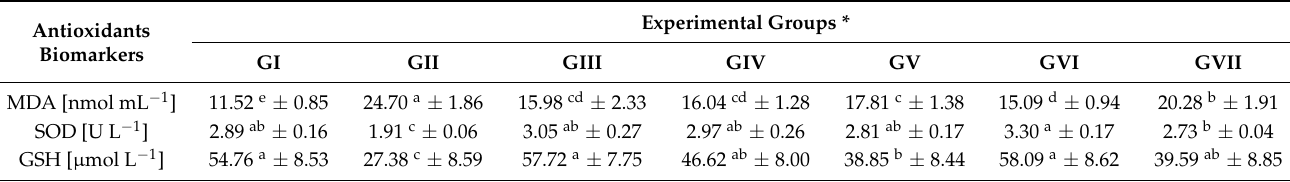
Table 5. Effect of SP, KF, KP, and SFP extracts on plasma antioxidants biomarkers of indomethacin-induced gastric ulcer in rats (mean ± SE), n =